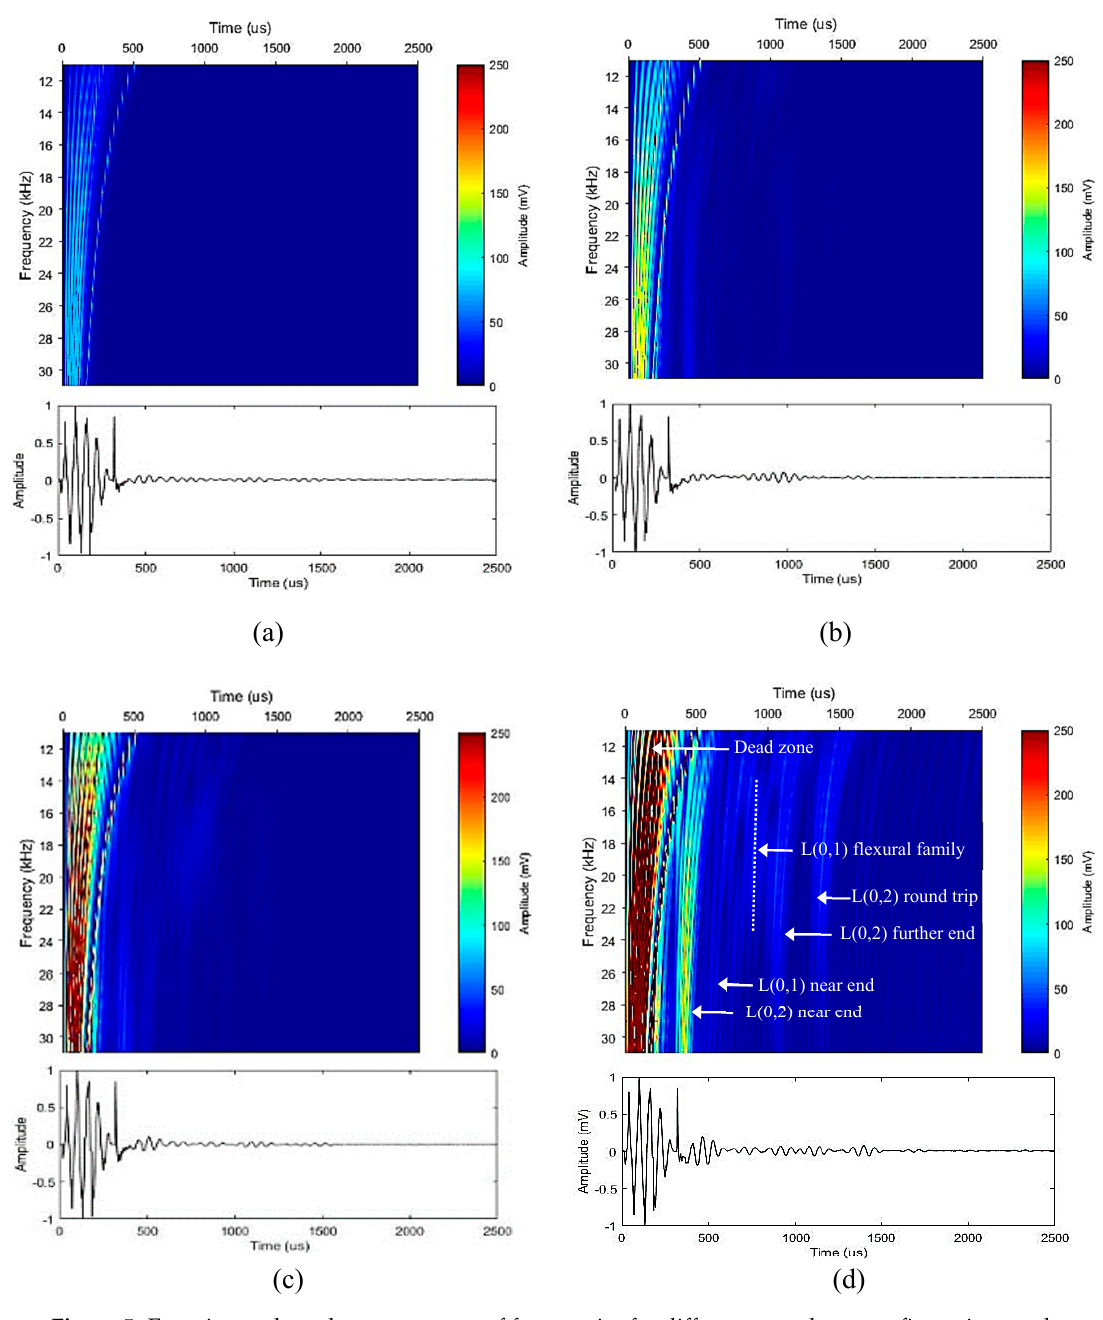
Figure 5. Experimental results over a range of frequencies for different transducer configurations and its corresponding time-domain results at 16 kHz: ( a ) one transducer; ( b ) two evenly spaced transducers; ( c ) four evenly spaced transducers; ( d ) eight evenly spaced transducers.